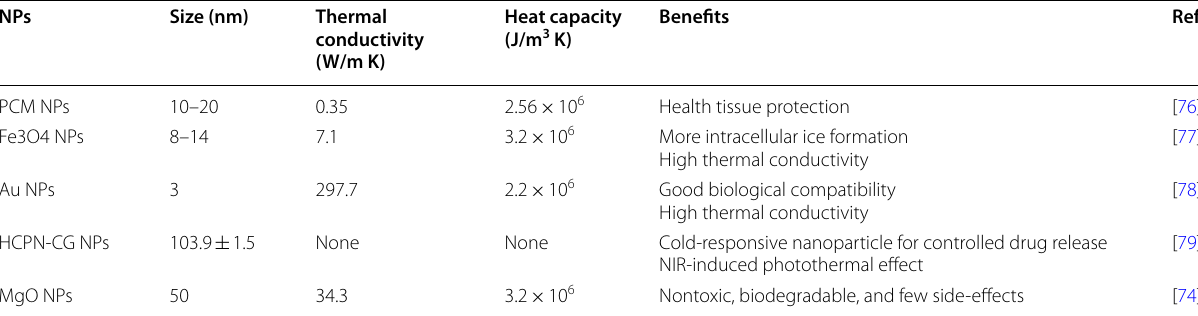
HCPN-CG H for hyaluronic acid, C for chitosan, P for PF127, N for PNIPAM-B, C for CPT, and G for ICG, PCM phase change materials